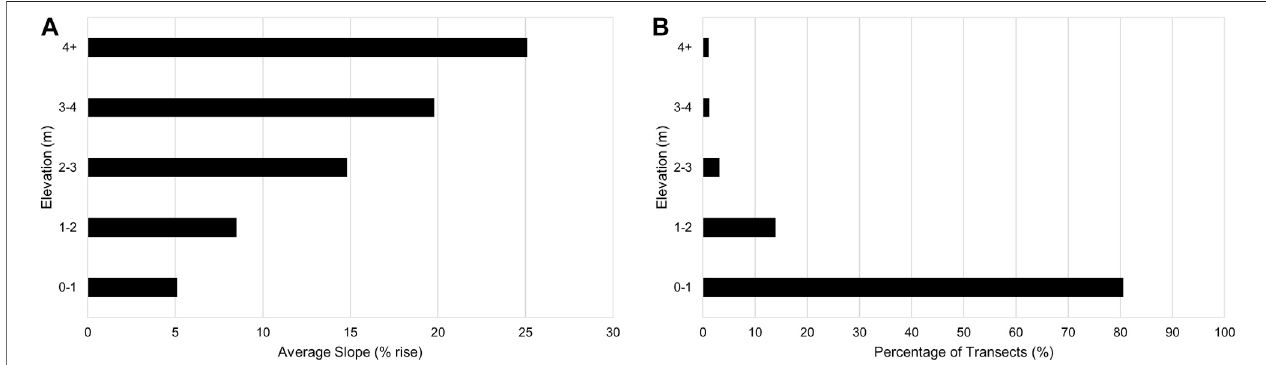
FIGURE 5 | Median slope value of transects within 10 regions comprised of the coastal counties surrounding the Chesapeake Bay. Locations of the two test sites for the accuracy assessments are depicted by white triangles. Locations of the three fi eld transects used to determine vertical uncertainty are depicted by black circles.